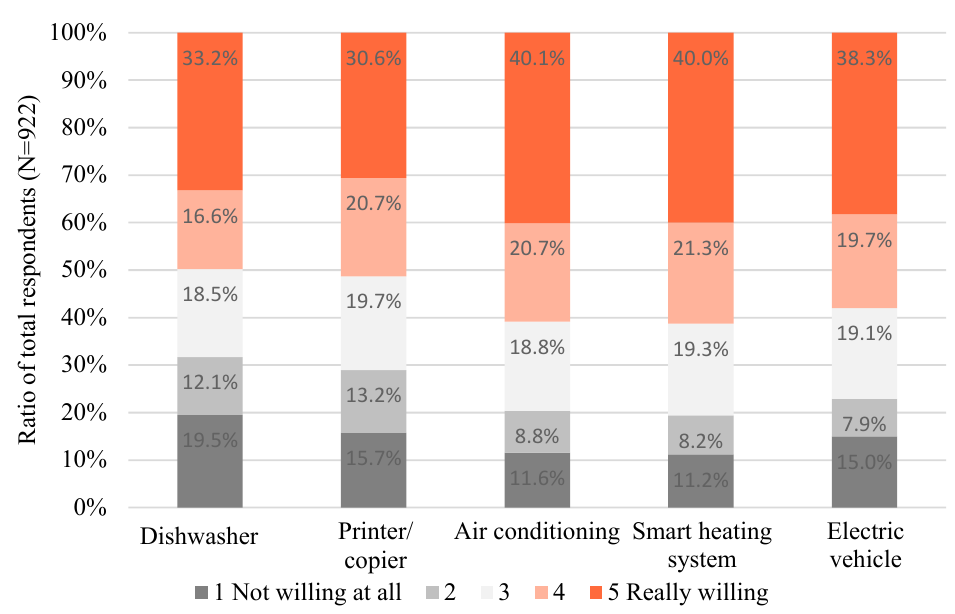
Figure 5. Willingness to follow the messages shown on the office energy display to manually turn on some smart appliances at the recommended time.